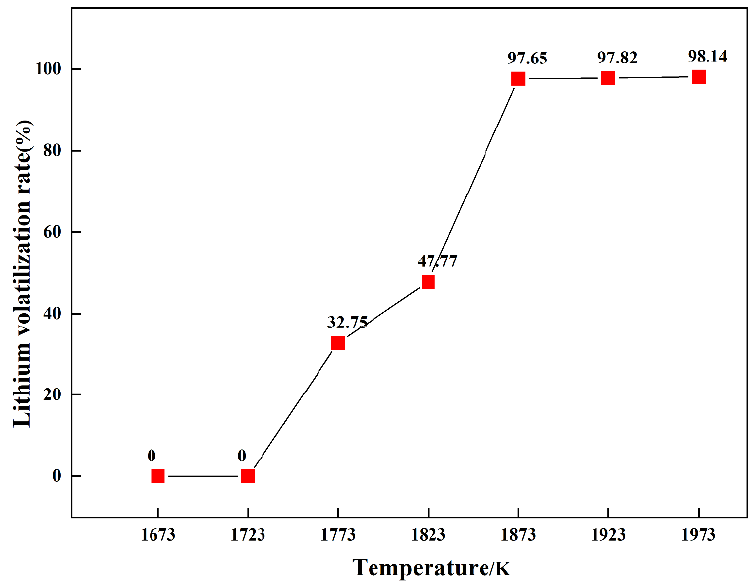
Figure 8. Reduction rates of lithium at varying reaction temperatures.